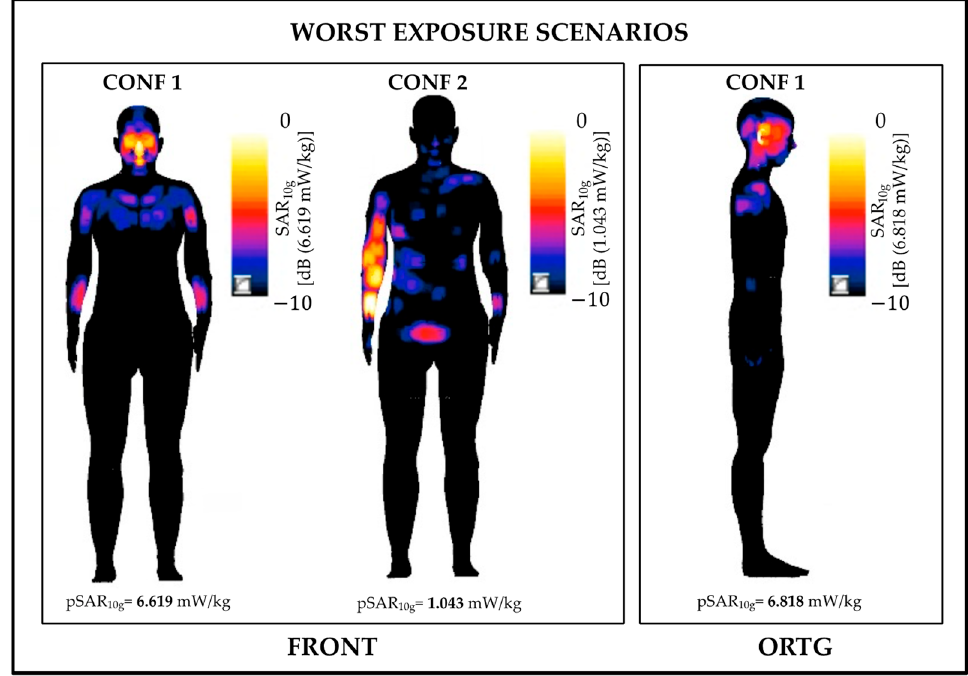
Figure 3. Distributions of SAR 10g on the skin tissue for the three cases where pSAR 10g was higher than 1 mW/kg. Note that the distributions in the three cases are normalized with respect to their pSAR 10g . As seen in Figure 3, in CONF 1, the highest SAR 10g values are localized at the head, namely, at the nose and eyes in the frontal orientation and at the ear region in the orthogonal one, whereas the torso and the arms showed lower SAR 10g values with respect to the